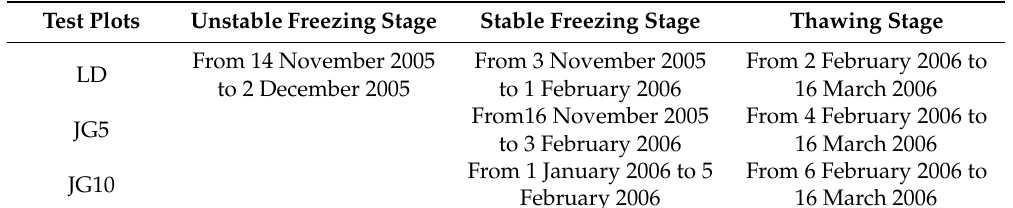
Table 3. Freezing and thawing characteristics of different test plots.